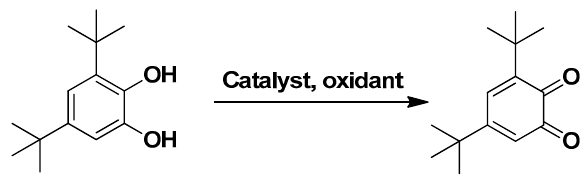
Figure 9. Schematic representation of the ( a ) asymmetric unit and ( b ) the crystal packing of MMPF viewed along [1,0,0] direction. (Colour scheme: bright green = Fe, dark yellow = Mn, gray = H, dark gray = C, light blue = N, red = O).